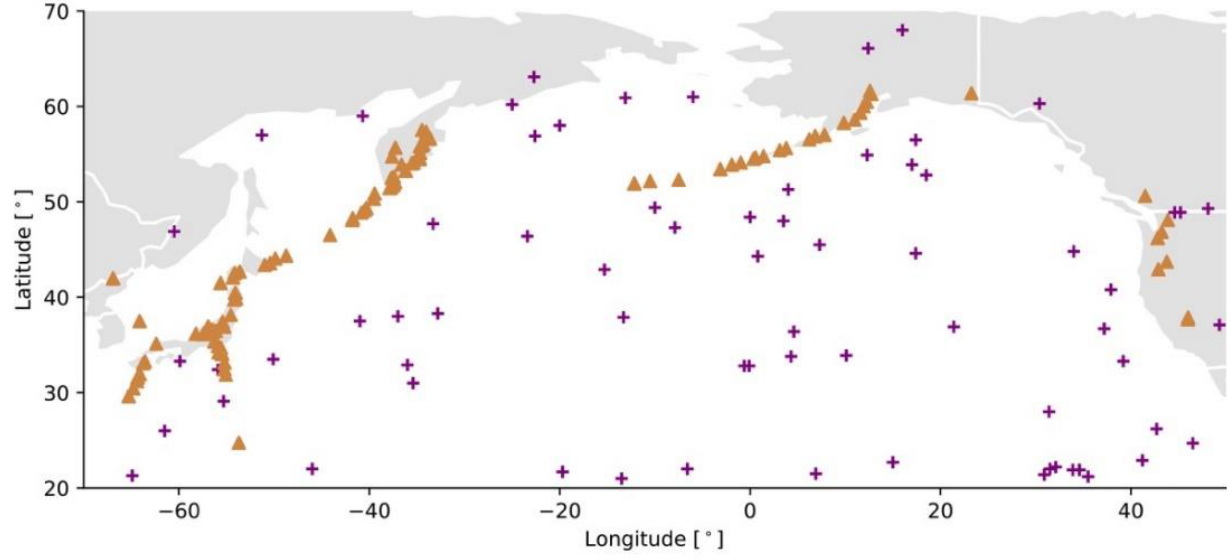
Figure 2. Examples of point sources (asteroid impact and volcanic eruption cases) in the North Pacific region. Fireball locations (plus signs) in the dataset of Fireballs Reported by US Government Sensors [38]. Active volcanoes (triangles) represented by the eruptions that occurred in the past 10,000 years in the LaMEVE database [50].